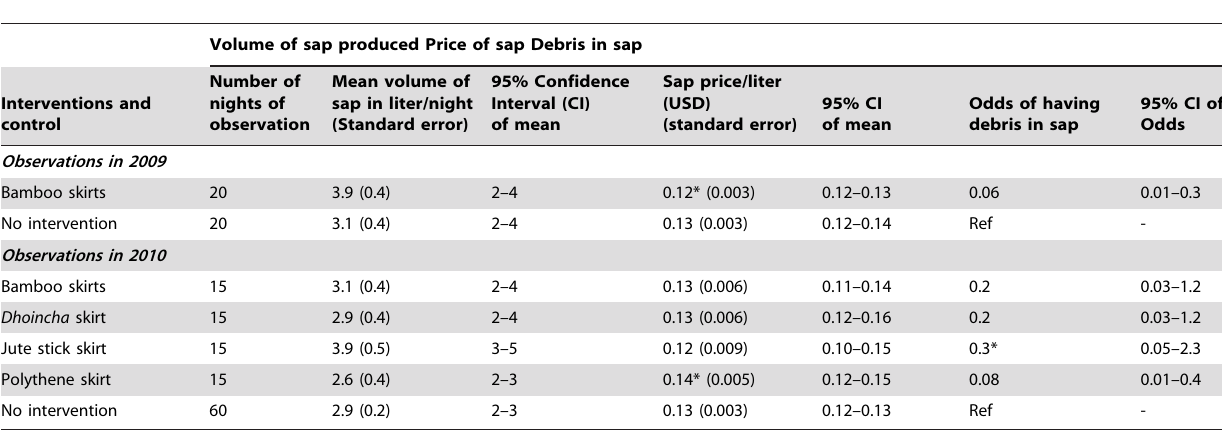
Table 2. Difference in debris presence, changes in volume of production and price of the sap harvested from date palm trees with and without skirt intervention in the 2009 and 2010 in